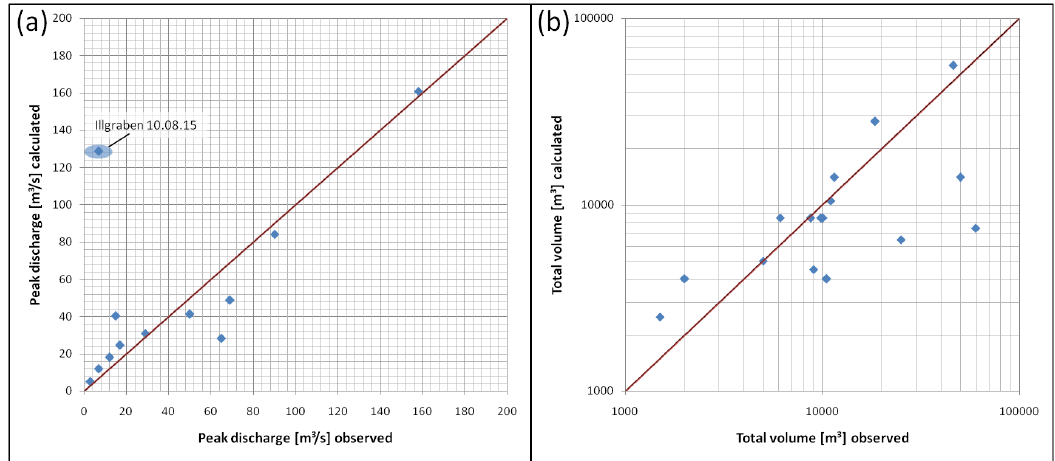
Figure 12. ( a ) comparison of the calculated peak discharge to the observed values; ( b ) comparison of the calculated total volume to the observed